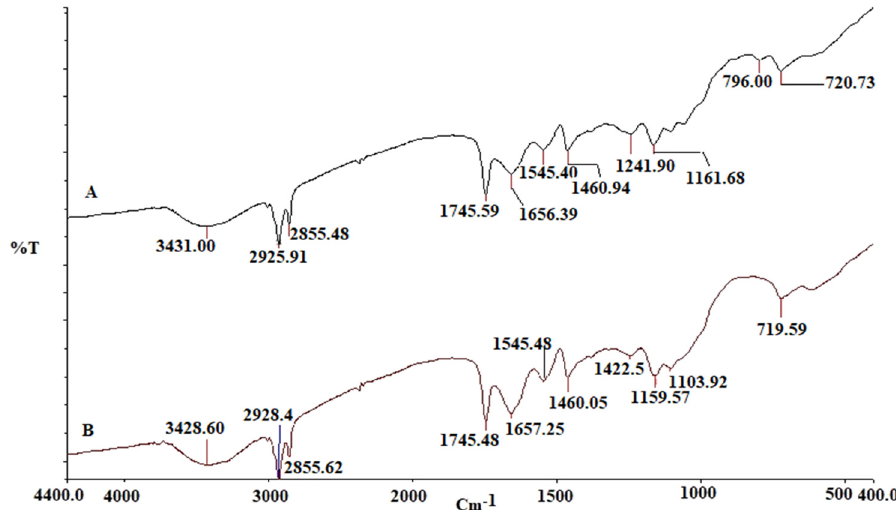
Figure 4: FTIR analysis of mustard seeds ( A ) and mustard seed nanoparticles ( B )